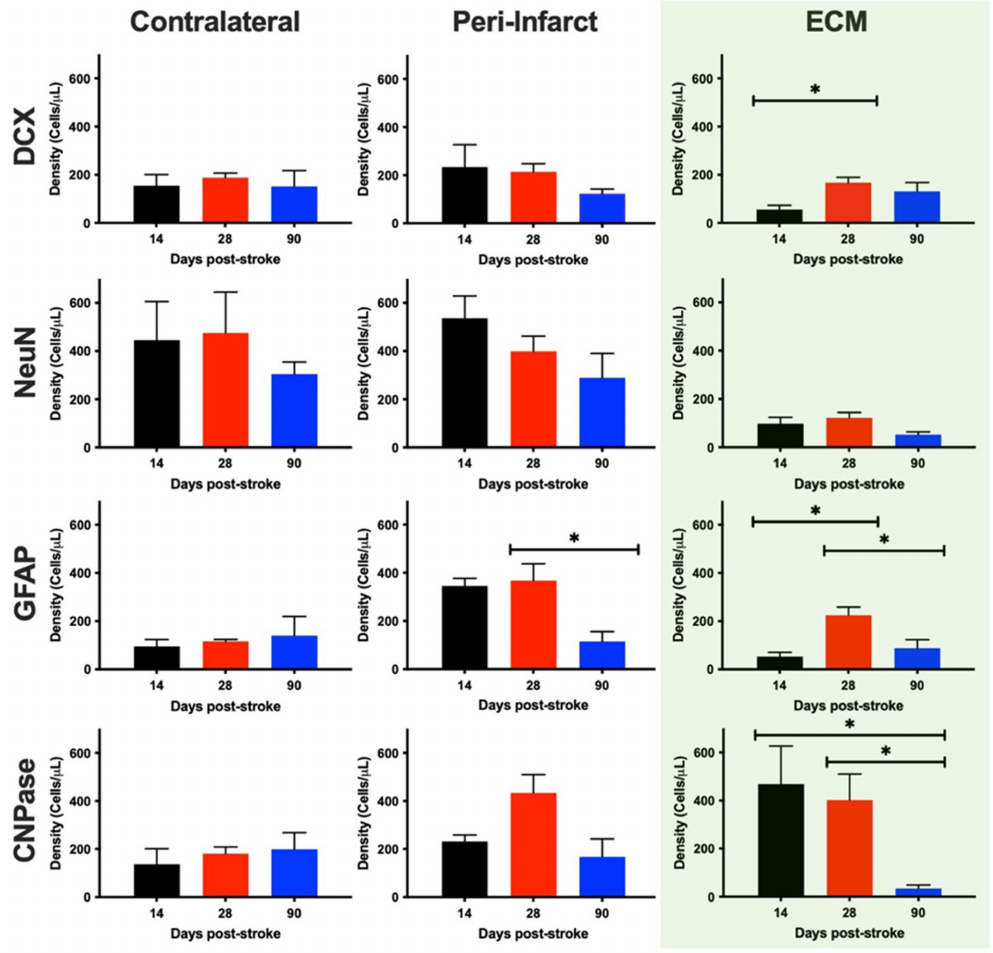
Figure 9. Phenotypic characterization and quantification of invading neural cells. To provide an anatomical context of cells within the bioscaffold, the same phenotypes were quantified in the contralateral and peri-infarct regions. To afford a comparison across different ECM hydrogel volumes, cell densities (cells/ µ L) were calculated. Within the bioscaffold, neural progenitors (DCX+ cells) infiltrated across all time points with the 28-days post-stroke time point yielding the highest density of progenitors, comparable to the levels found in the contralateral and peri-infarct regions. In contrast, mature neurons (NeuN+) were dramatically reduced in the bioscaffold, but there was no difference in content based on when the ECM hydrogel was implanted. Astrocytes (GFAP+) exhibited the greatest density in peri-infarct regions. Within the ECM hydrogel, a peak astrocyte content was evident in the 28-days post-stroke condition. Oligodendrocyte (CNPase+) density was increased in the peri-infarct region and was highest within the bioscaffold if these were implanted between 14- and 28-days post-stroke. An almost complete lack of oligodendrocytes with the ECM hydrogel occurred in the 90-days post-stroke condition. (* p <